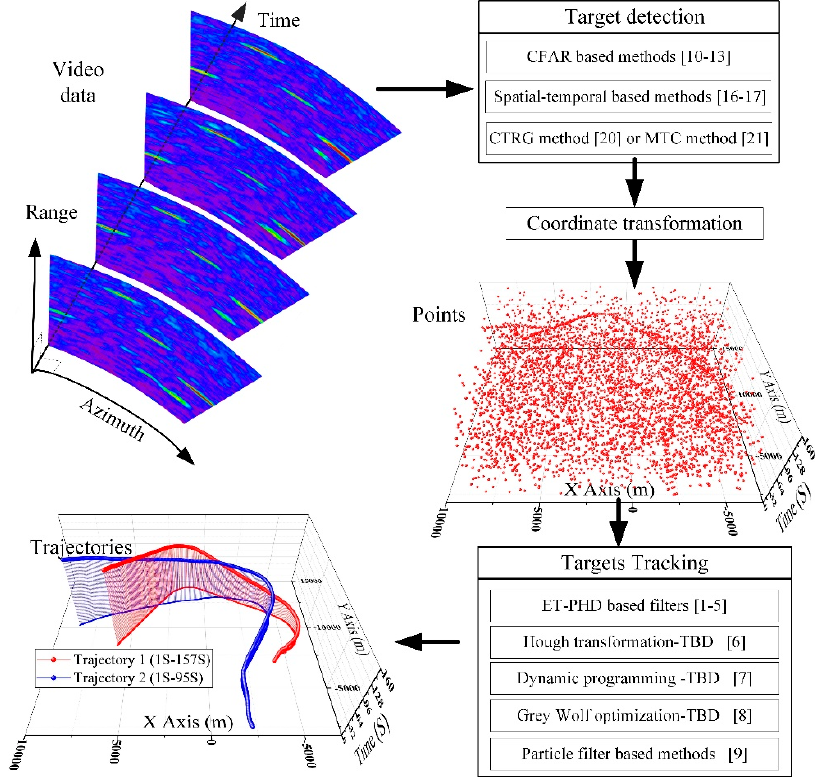
Figure 1. The schematic diagram of radar data processing.